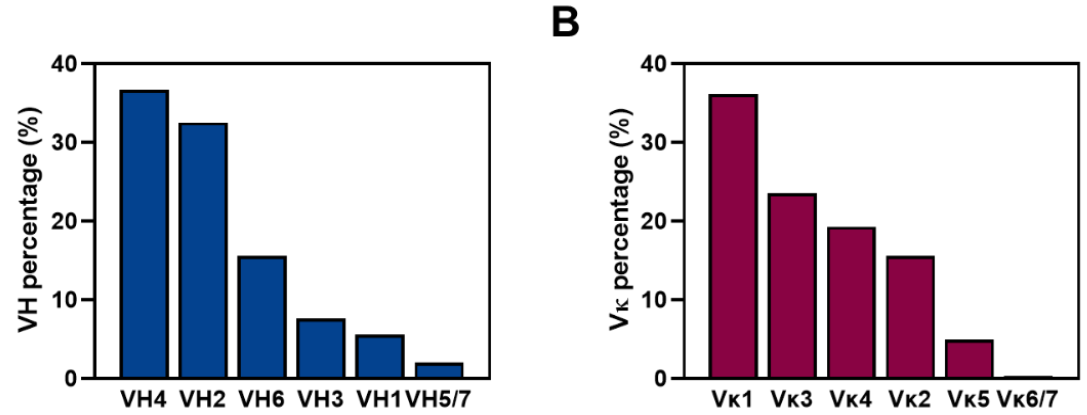
Figure 3. Abundance of each variable domain subfamily observed in the constructed library. Fol- lowing the germline classification of the antibody sequences in the library, each heavy chain variable (blue) ( A ) and κ light chain variable (red) ( B ) domain subfamily is depicted using percentage bar graphs in descending order.